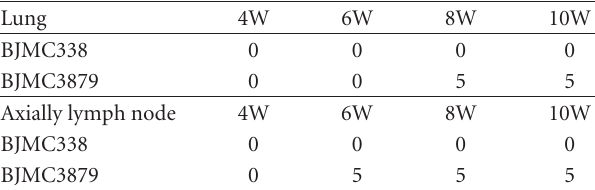
Table 1: Number of mice which have lung and axially lymphnode metastases. Metastases were confirmed by H&E